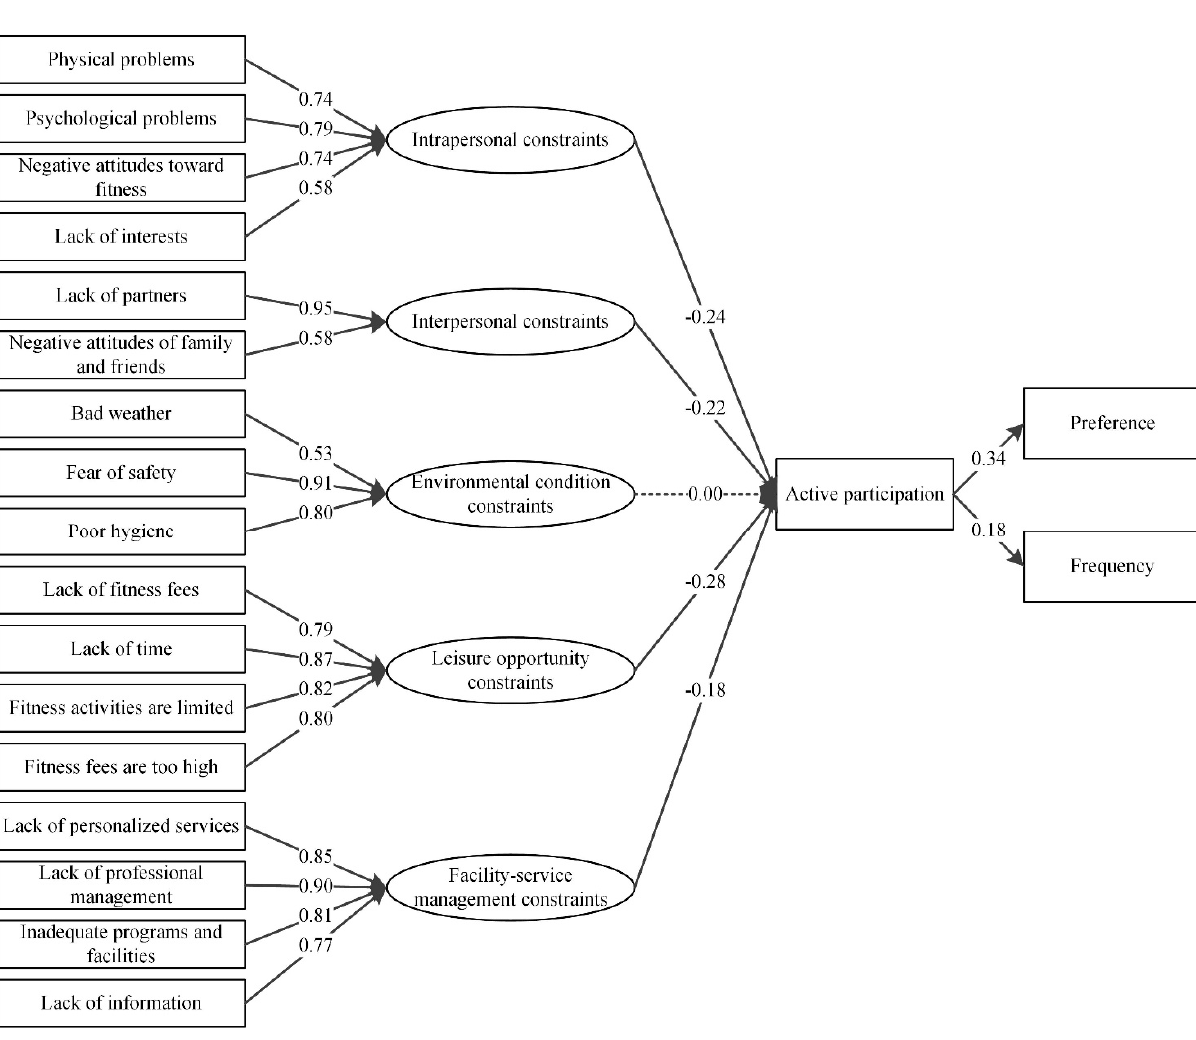
Figure 3. The path of standardized estimates for male groups in the structural residuals model.